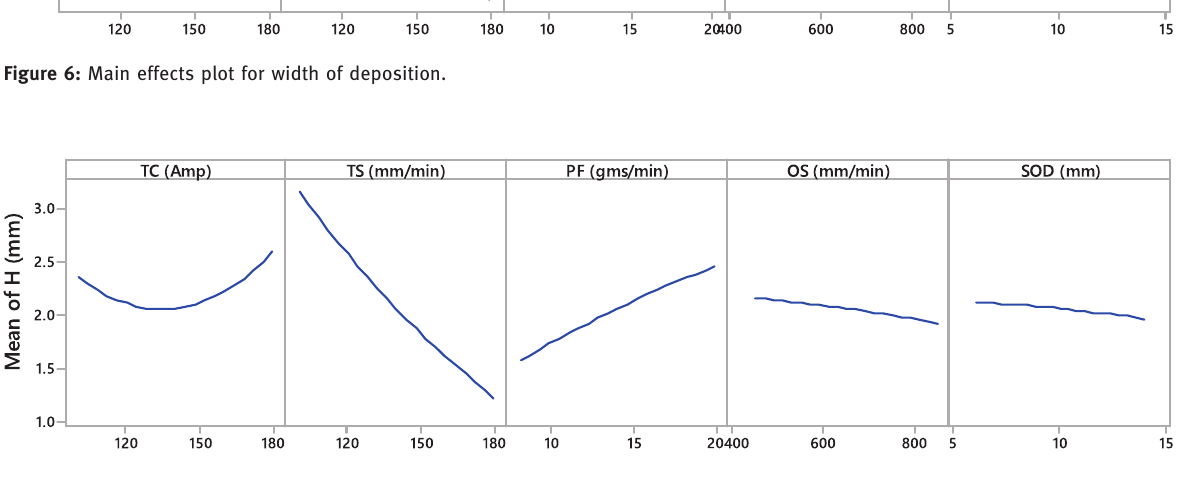
Figure 7: Main effects plot for